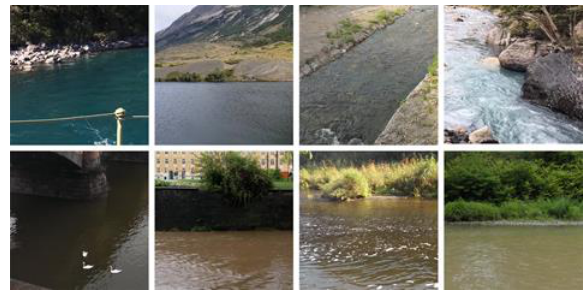
Figure 2. Appearances of different running waters, captured with varying camera